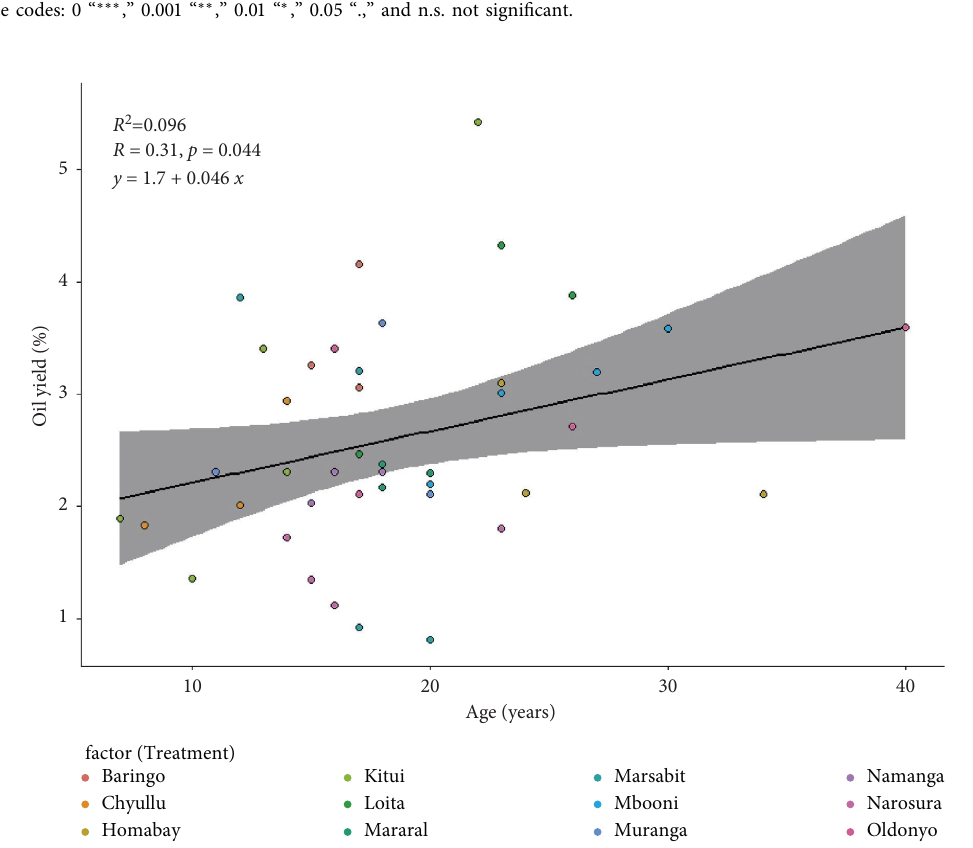
Figure 2: Age versus oil yield. NB: Meaning of shaded part: Tis layer adds both the best-ftting regression line and also the 95% confdence interval for the line shown in grey shading. Te outer edges of the shaded area represent the confdence bands, indicating the 95% confdence intervals for the mean of the Y -variable (Oil yield) at each value of the X -variable (tree age).